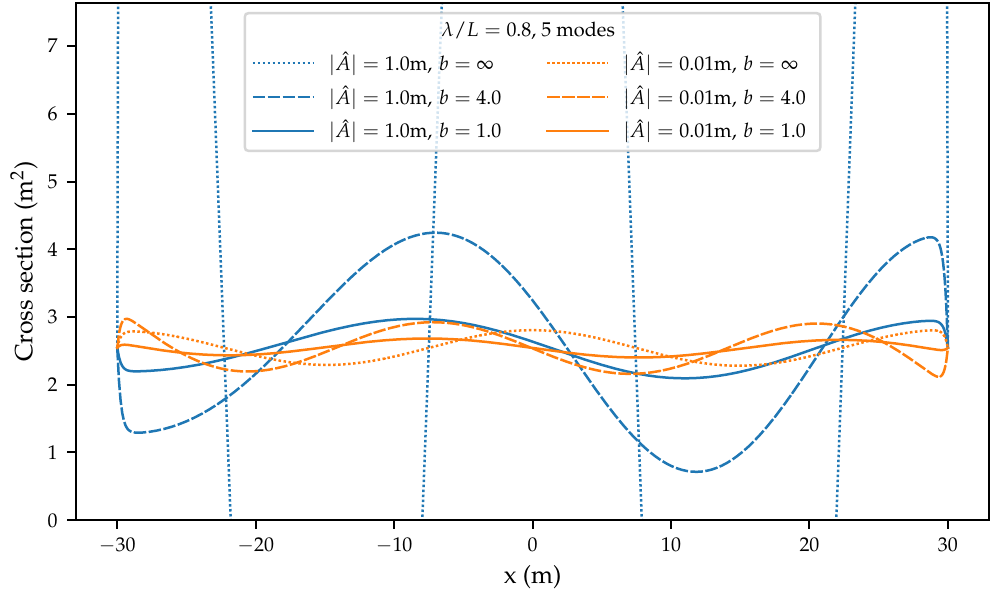
Figure 4. Cross section at a given time of a cylinder with length L = 60m and radius r S = 0.9m following its maximal motion predicted while using the first five modes of deformation for waves of wavelength λ = 0.8 L traveling in the direction of the device, for several incoming wave amplitudes | ˆ A | and several constraints b